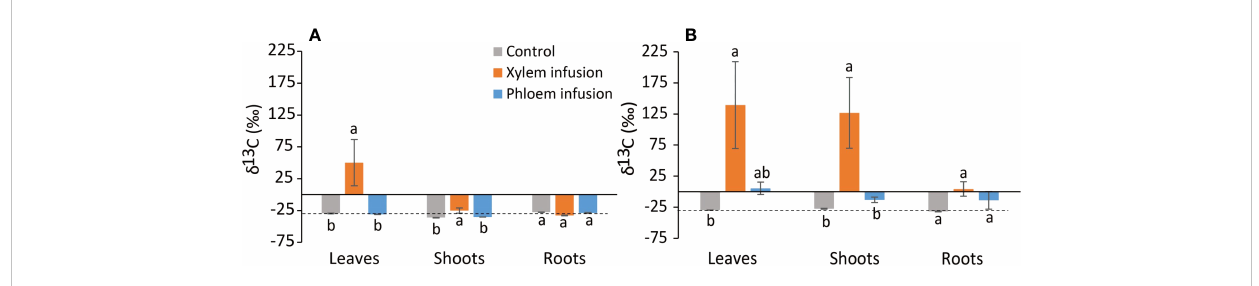
FIGURE 2 Effects (n = 3 – 5, mean value ± 1 SE) of xylem infusion (orange color) and phloem infusion (blue) with 13 C-labelled glucose into Ficus microcarpa bonsai trees compared to controls (grey) under greenhouse conditions (see Figure 1). Samples were taken three (A) and ten (B) weeks after the infusion started. The dashed lines correspond to the average natural 13 C abundance (~ -26 ‰ d 13 C) in European trees (Taylor et al. 2003; Zeller et al. 2007). Different lowercase letters indicate signi fi cant differences in d 13C values of tissue (i.e., leaves, shoots, or roots) among the treatment xylem infusion, phloem infusion and controls (P <